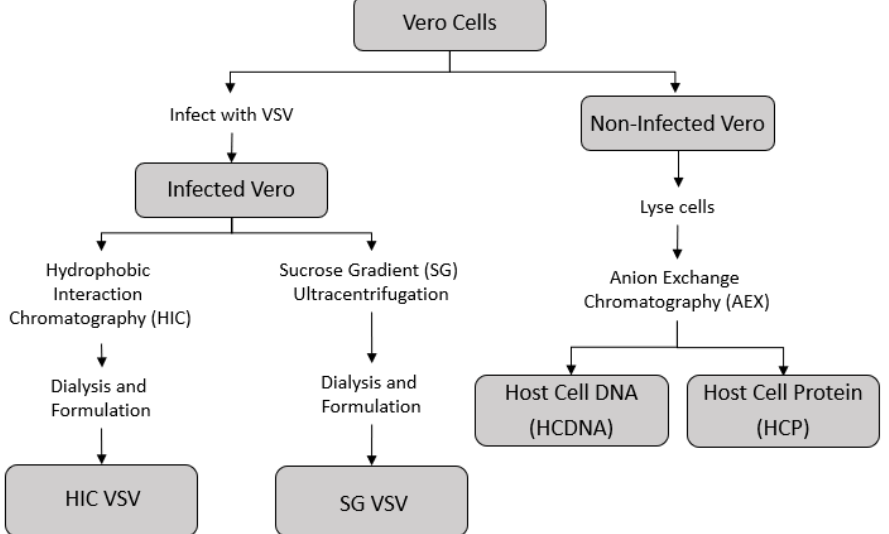
Figure 1. Outline of the process by which the different feed solutions for the sterile filtration experiments were prepared. The supernatant from infected Vero cells containing the vesicular stomatitis virus (VSV) was collected and purified using either hydrophobic interaction chromatography (HIC VSV) or sucrose-gradient ultracentrifugation (SC VSV)—see Table 1 for the corresponding amounts of host cell impurities in each purified VSV solution. Concentrated stocks of host cell DNA and host cell protein were prepared from a non-infected Vero cell culture using an anion exchange chromatography